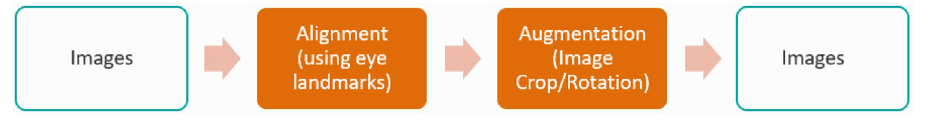
Figure 5. Preprocessing pipeline for model